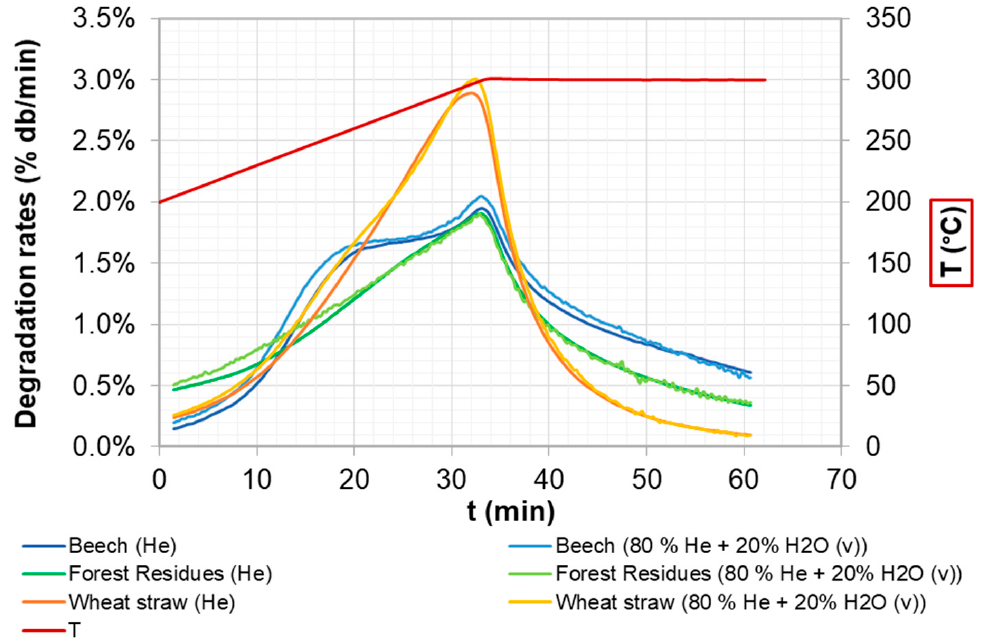
Figure 6. Degradation rate versus time and temperature obtained during torrefaction of beech, forest residues and wheat straw in a TGA under dry (He, 100% v/v ) and moist (H 2 O/He, 20% v/v ) atmospheres.